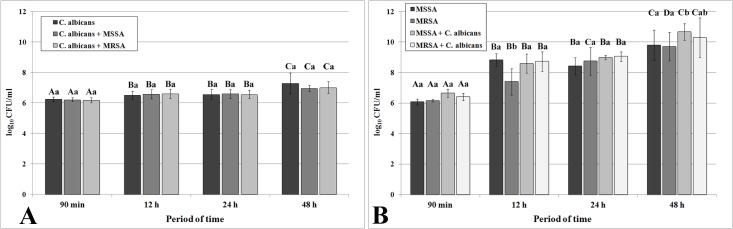
Mean log10 CFU mL-1 values for grown of C. albicans (A), MSSA and MRSA (B) as single- and dual-species grown in RPMI at 37°C.Error bars represent standard deviation. The uppercase letters show differences among time periods and lowercase letters show differences among the growth conditions (Tukey post-hoc test at ρ>0.05).